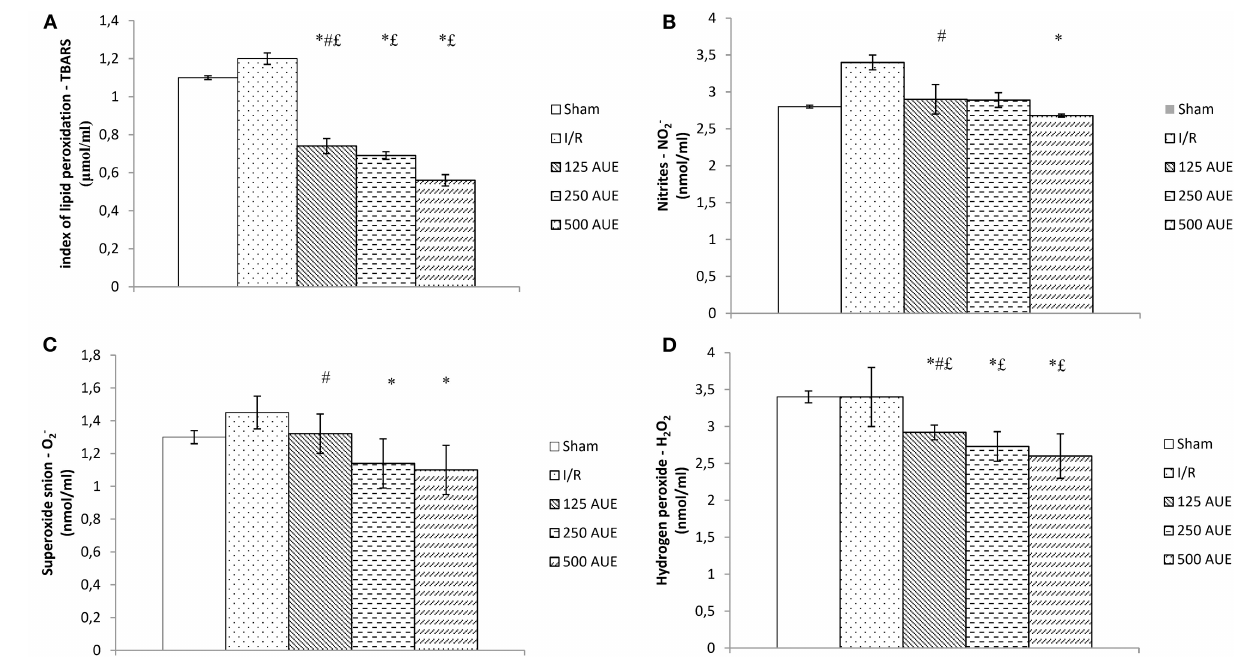
FIGURE 3 | Effects of consumption of increasing doses of AUE on the value of pro-oxidative markers in plasma samples measured as index of lipid peroxidation (TBARS) (A) , NO 2 − (B) , superoxide anion (C) , H 2 O 2 (D) ( n = 50, 10 animals per group). Values are shown as mean ± SE. *Statistically significant difference at the level of p < 0.05 in relation to the I/R group; # Statistically significant difference at the level of p < 0.05 compared to 500AUE; £ Statistically significant difference at the level of p < 0.05 compared to sham. n = 10 animals per